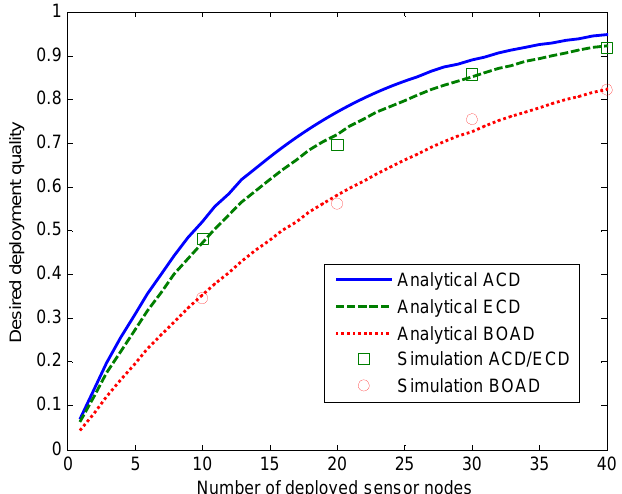
Figure 10. Effects of number of deployed sensor nodes on the DDQ for r = 15 m.